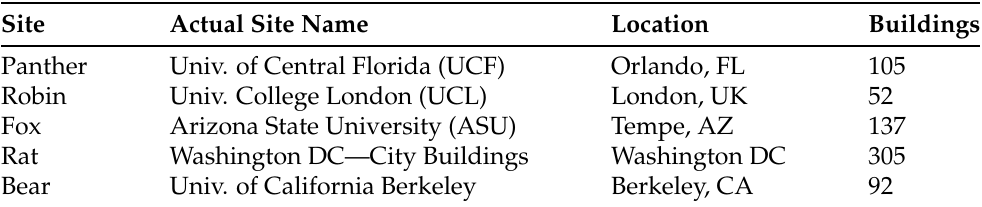
Table 2. Overview of the sites from which the meter data were collected and number of buildings having electricity meter readings for each